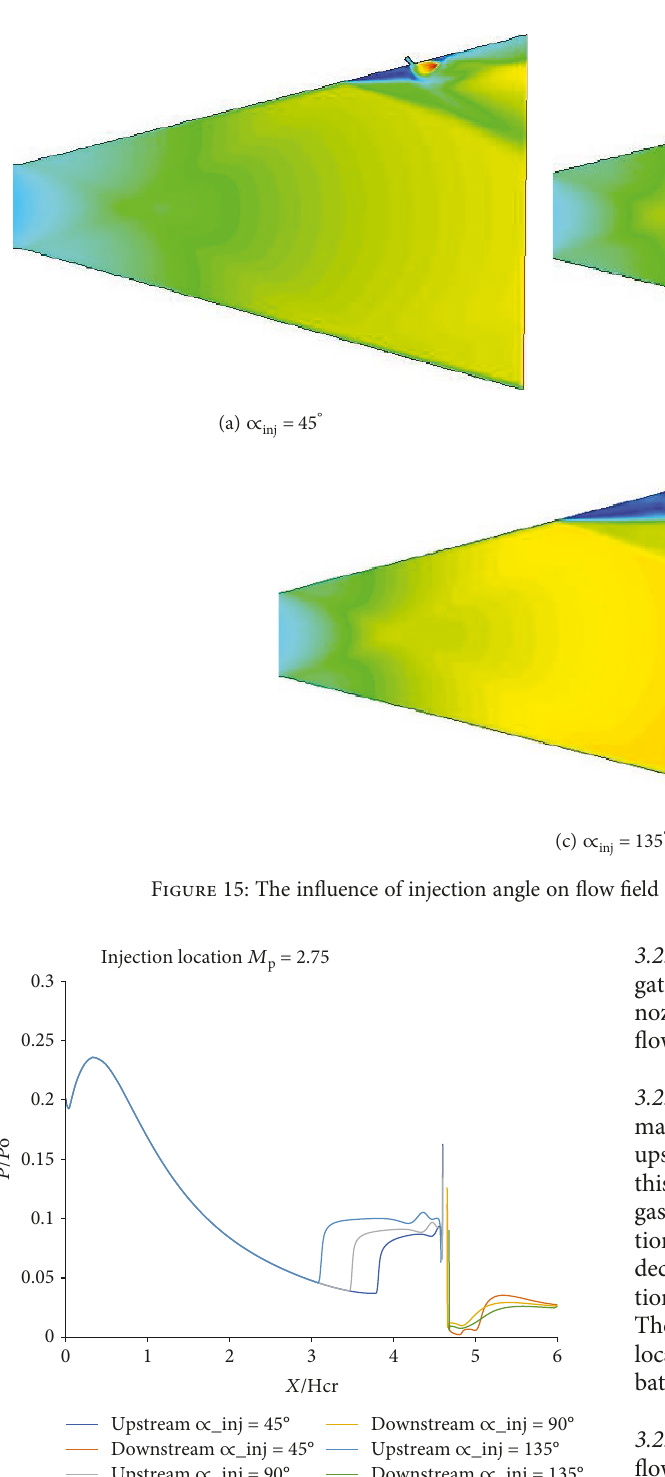
Figure 16: In fl uence of the injection angle on the static pressure distribution along the injector wall M